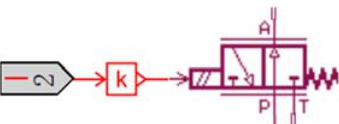
Figure 20. AMESim submodel and structure diagram of pilot inlet and exhaust solenoid valves.